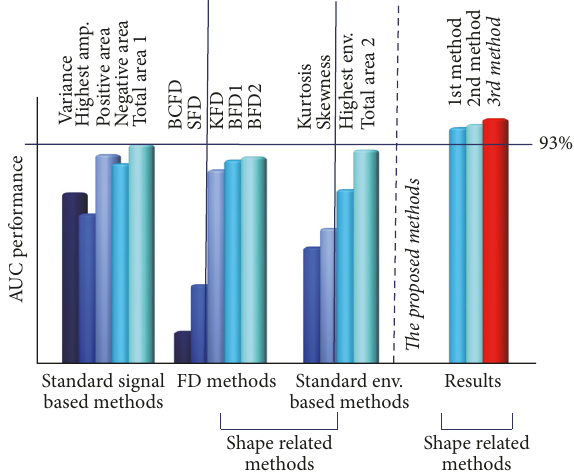
Figure 3: AUC performance of the proposed methods and other tested methods which are characterized by AUC >